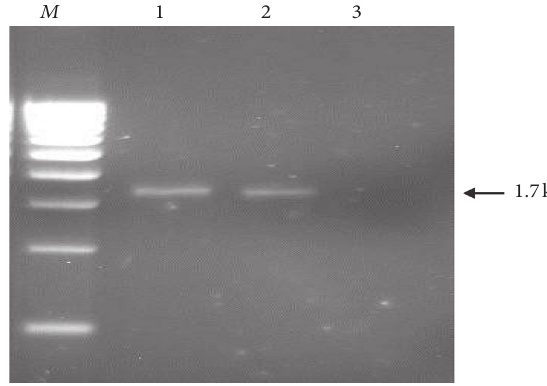
Figure 1: Agarose gel electrophoresis of the products amplified with PCR using the specific primers for α- amylase gene. M; 500bp DNA ladder, Lane 1; B. licheniformis , Lane 2; B. cereus , Lane 3; negative